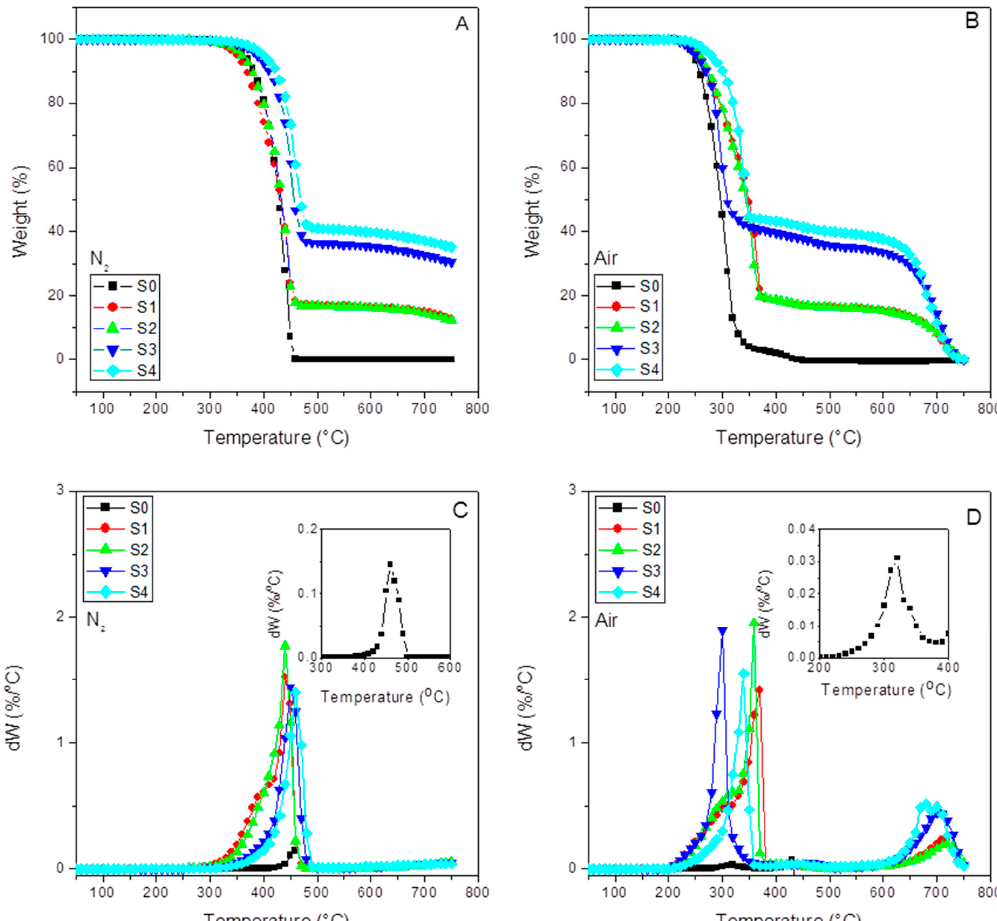
Figure 2. TGA and DTG curves for the indicated samples under inert ( A , C ) and oxidative ( B , D ) conditions. The DTG curves for S0 have been also included as inserts.